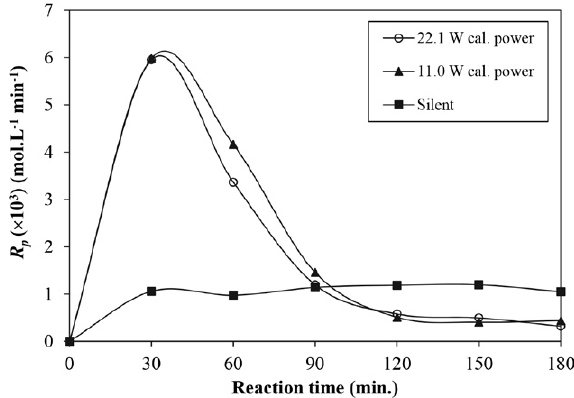
Fig. 3. Rate of polymerization versus reaction time at different ul- trasound calorimetric powers (APS: wt. % 2, SDS: wt. % 0.5).